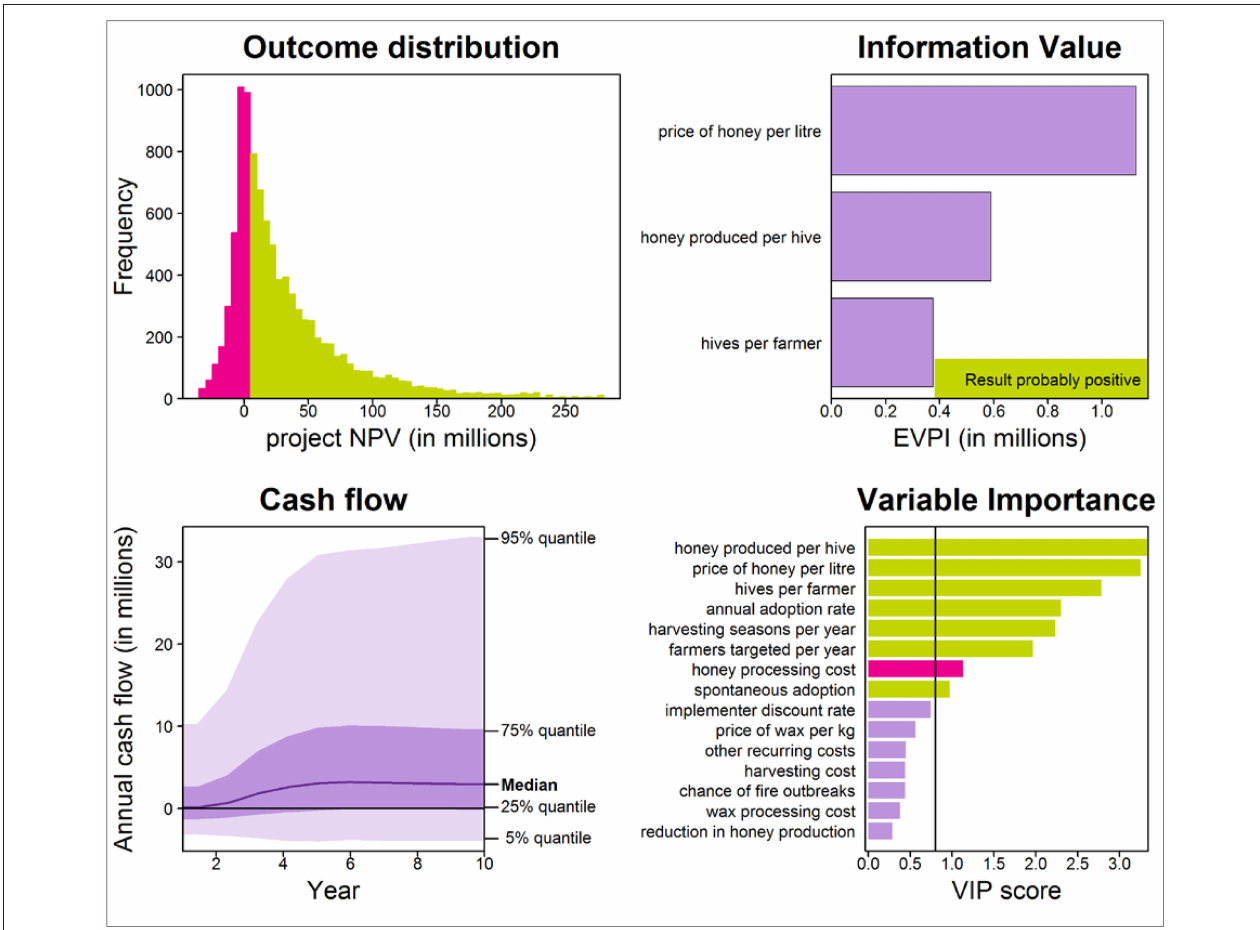
FIGURE 5 | Projected outcome distribution (top left), high-value variables (EVPI; top right), project cash flow (bottom left) and important variables (determined by PLS regression; bottom right) for the overall project in Witu, Kenya. Results were produced through Monte Carlo simulation (with 10,000 model runs) of project performance over 10 years. Red and green bars in the outcome distribution indicate positive and negative values, respectively. In the PLS plot, green bars indicate positive correlations of uncertain variables with the outcome variable, while red bars indicate negative